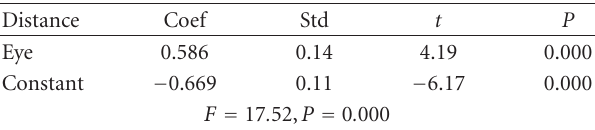
Table 8: Dominant eye